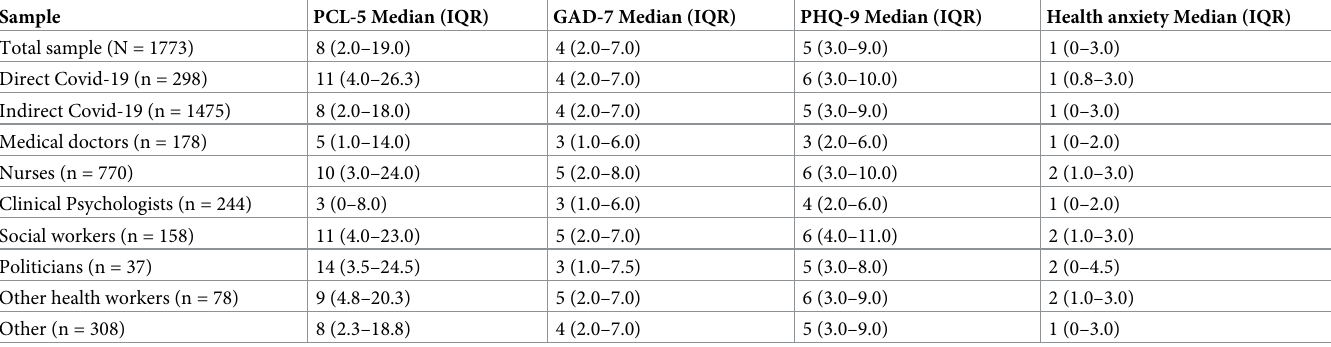
Table 3. Scores of post-traumatic symptoms, anxiety, depression and health anxiety in total sample and subgroups.